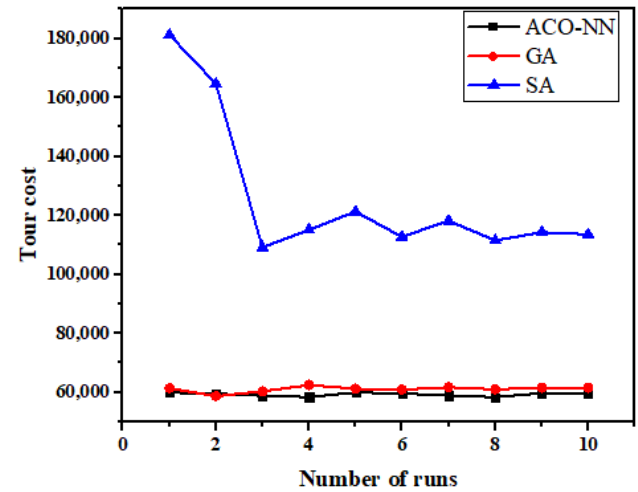
Figure 5. Comparison of ACO-NN to GA and SA for Pcb442.